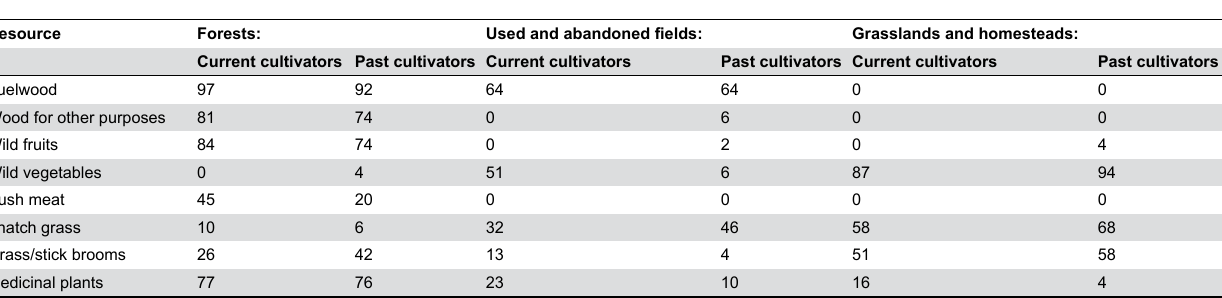
Table 5. The proportion (%) of current (n=31) and past cultivators (n=50) that collect NTFPs from three different land use types (N =